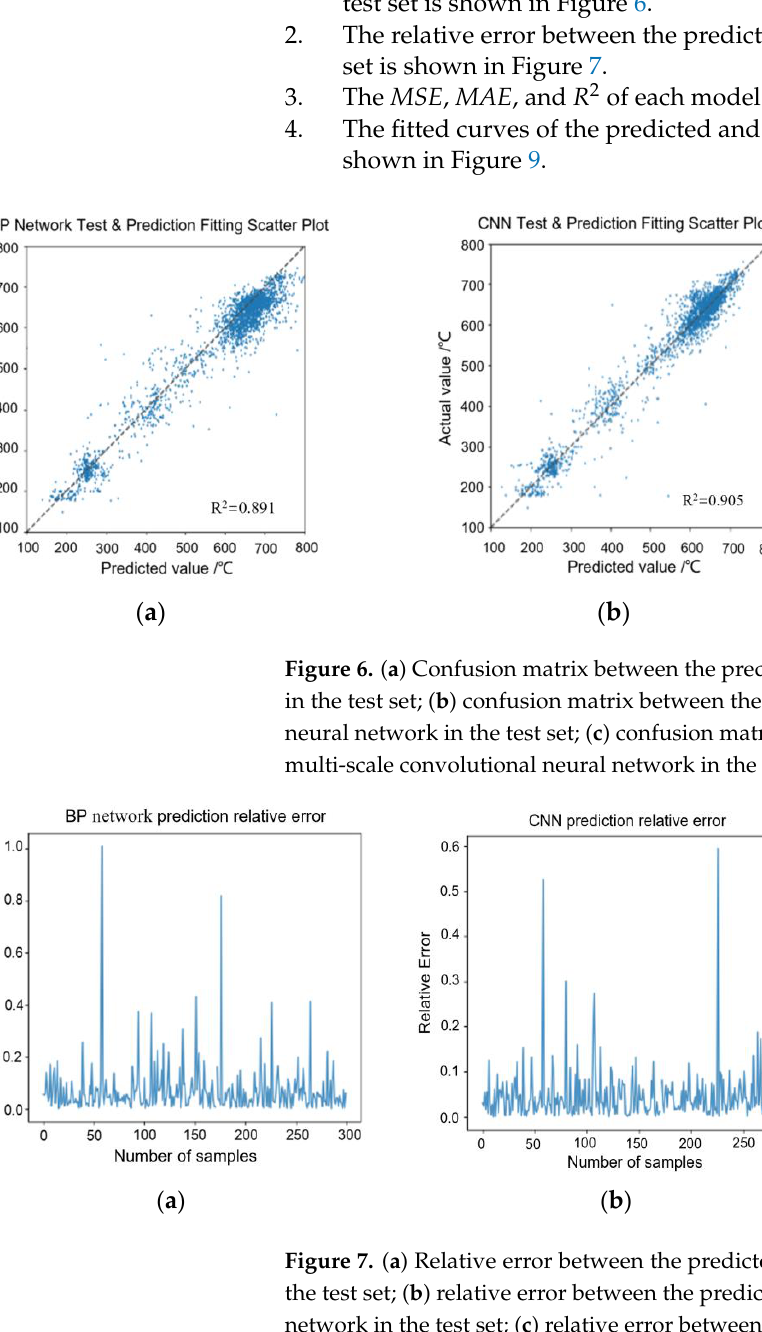
Figure 8. ( a ) MSE of each model in the test set; ( b ) MAE of each model in the test set; ( c ) R 2 of each model in the test set.